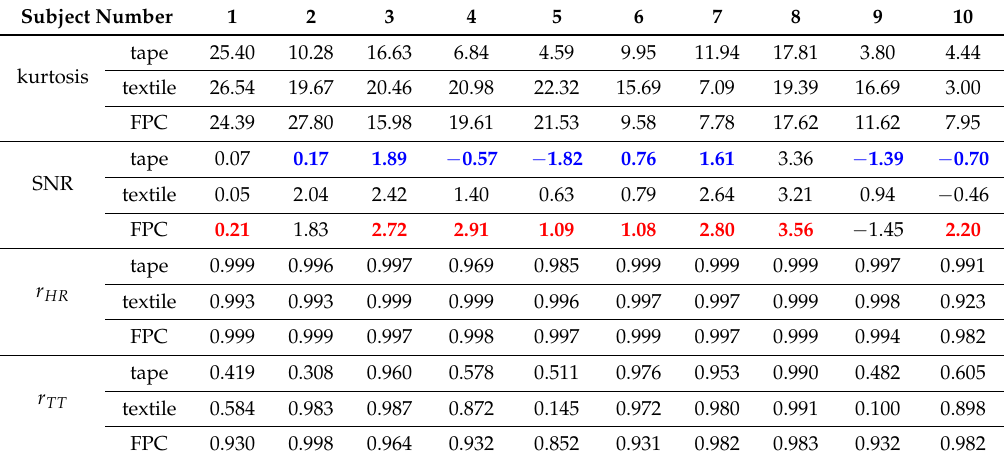
Table 6. Quality indexes of ECG signals measured in the lying supine posture. (The blue number show that the SNR of the copper foil tape on eight subjects is the smallest, and the red numbers show that the SNR of the FPC on eight subjects is the largest.)